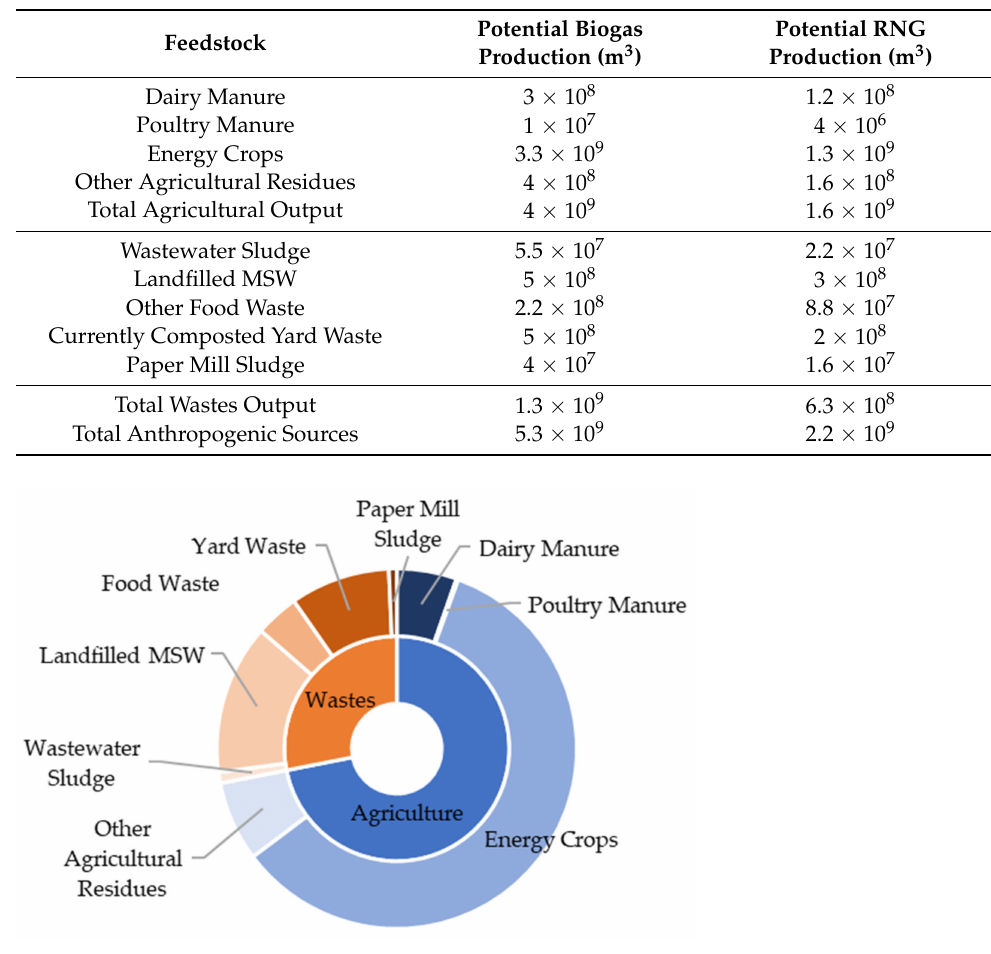
Table 3. Anthropogenic annual biogas generation potential in New York State.